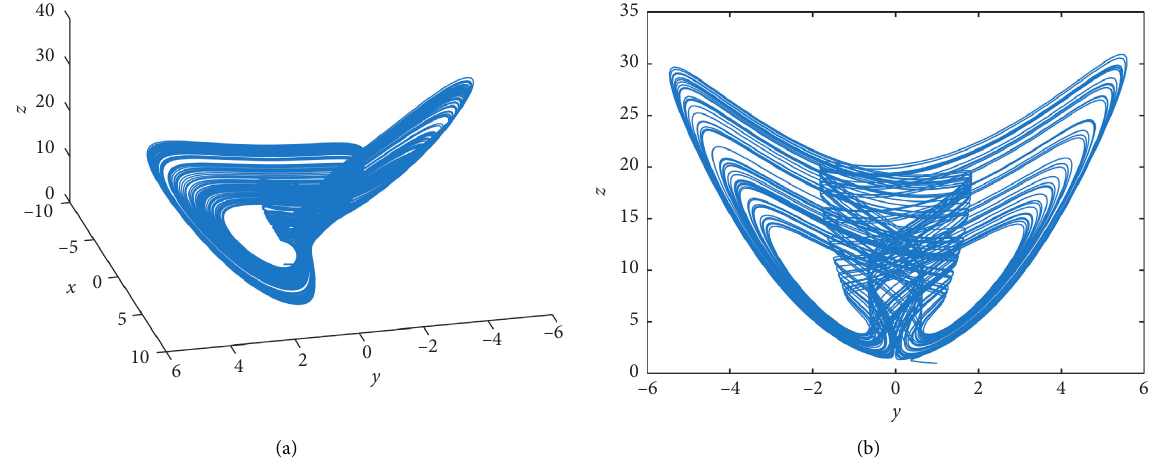
Figure 16: Phase portraits of the fractional system with c � 3 . 5 and α � 0 .